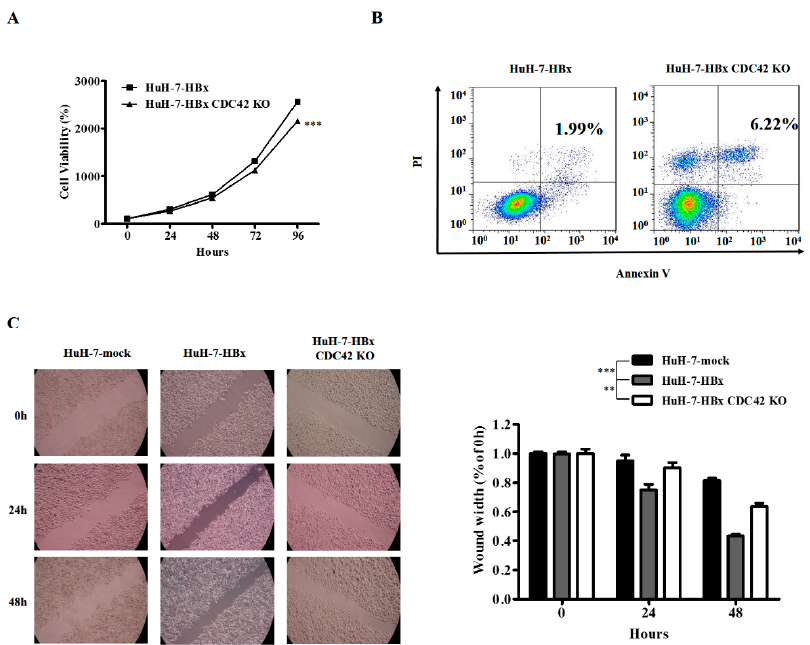
Figure 3. CDC42 was required by HBx to stimulate proliferation, wound closure, and inhibit apoptosis of HuH-7 cells. ( A ) The proliferation rate of HuH-7-HBx and HuH-7-HBx CDC42 KO cells was measured over 4 days. *** p < 0.001. Data represent the mean ± SEM of three different experiments; ( B ) cell apoptosis of HuH-7-HBx and HuH-7-HBx CDC42 KO cells was measured by flow cytometry; ( C ) analysis of cell migration in HuH7-mock, HuH-7-HBx, and HuH-7-HBx CDC42 KO cells, as measured by a wound-healing assay. Left: Representative photographs taken at 0, 24, and 48 h post-wound (×20). Right: The wound closure was quantified at 0, 24, and 48 h post-wound by measuring the remaining unmigrated area using ImageJ. ** p < 0.01. *** p < 0.001. Data represent the mean ± SEM of two different experiments.